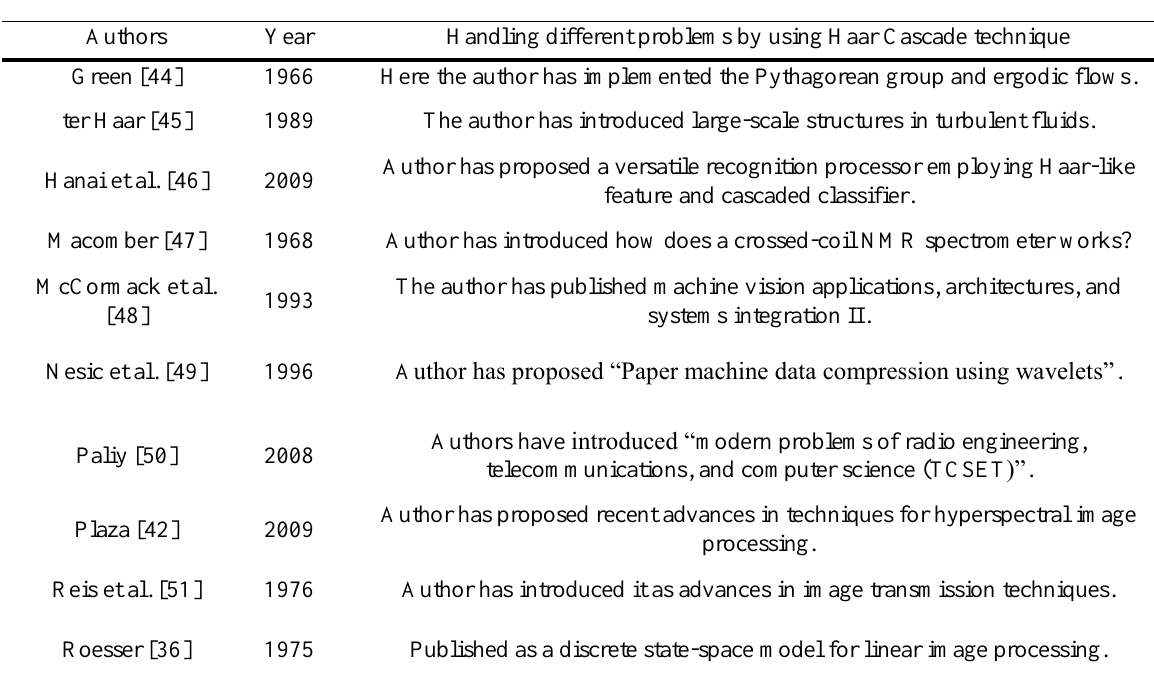
Table 2. A literature review of the Haar Cascade